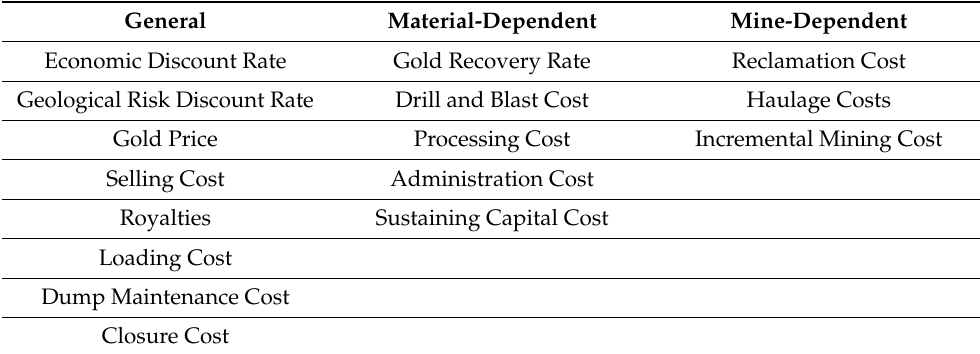
Figure 1. Material flow diagram at the gold mining complex considered in this case study. Table 1. Economic parameters.